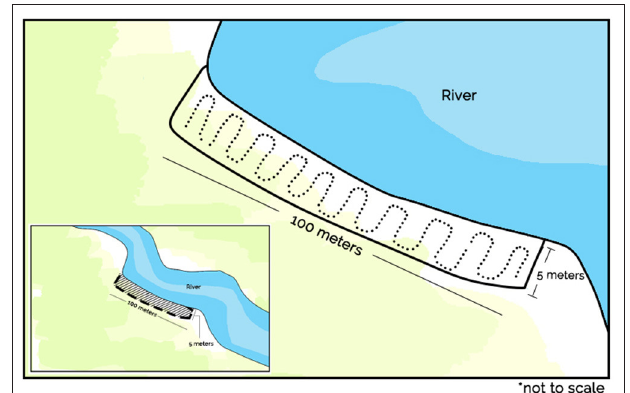
FIGURE 1 | How a collection area should be sited along a river including the recommended walking pattern adapted from Opfer et al. (2012) to a riverside collection site (Illustration by K. Owens and P.